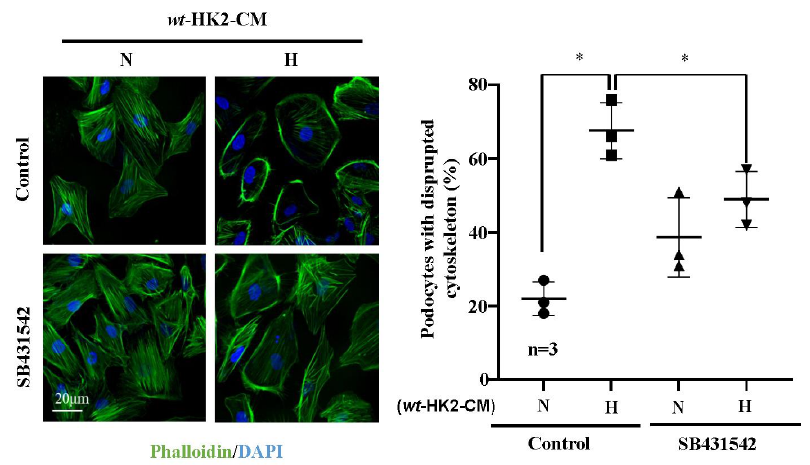
Figure 4. Hypoxic HK2 enhances cytoskeleton filament derangement in podocytes through TGF- β1. Experiments were performed as described in Figure 3E and subjected to Phalloidin staining of cytoskeletal actin fibers (green) in human podocytes. Nuclei were stained with DAPI (blue). Quantification of the podocytes with disrupted actin cytoskeleton (in percentage) is presented in the graph on the right. * p < 0.05 between the indicated groups. n = 3; CM: conditioned media, N: normoxia, H: hypoxia. SB431542: TGF- β 1 receptor 1 inhibitor.